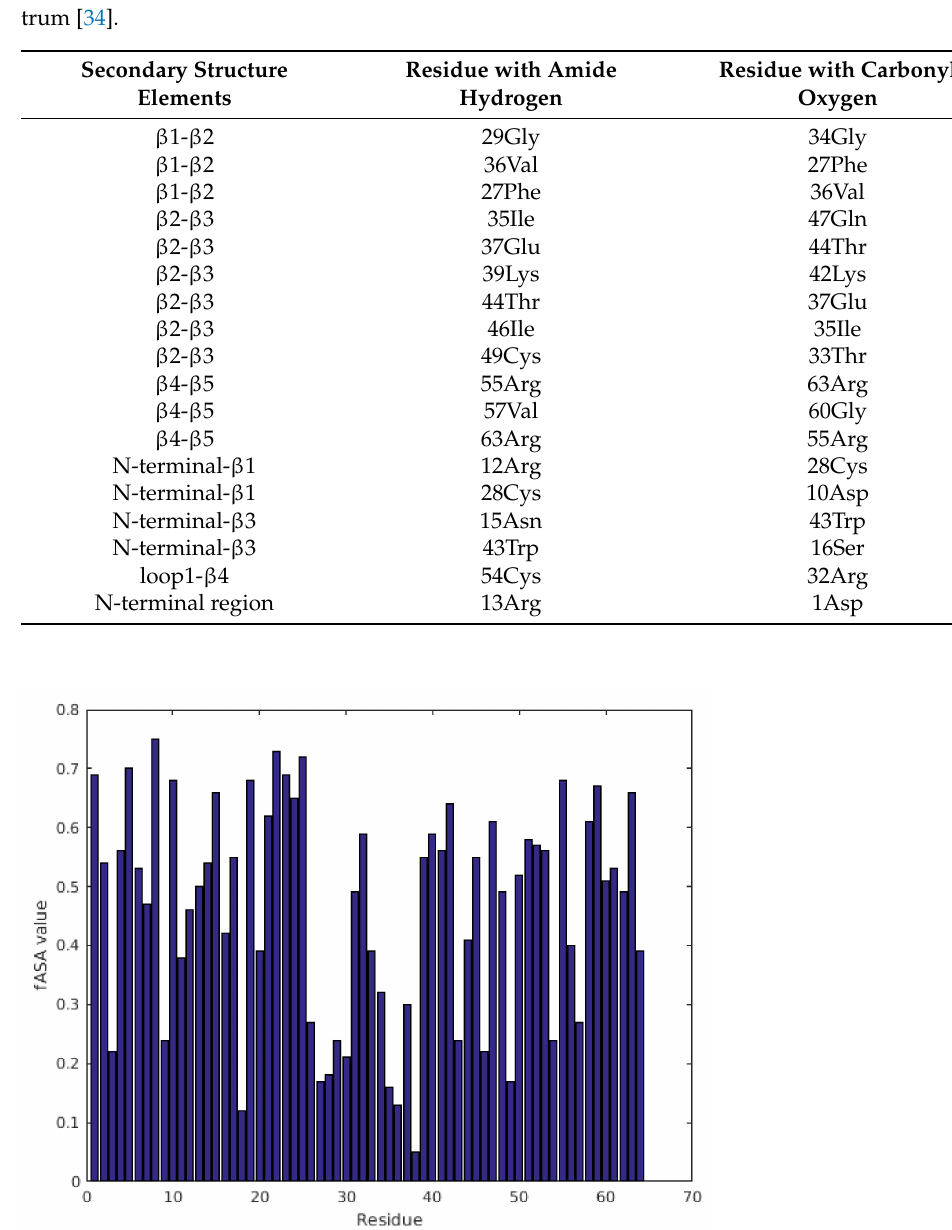
Table 1. Observed long-range hydrogen bonds in PAFC, identified in the hncogphb3d NMR spec-